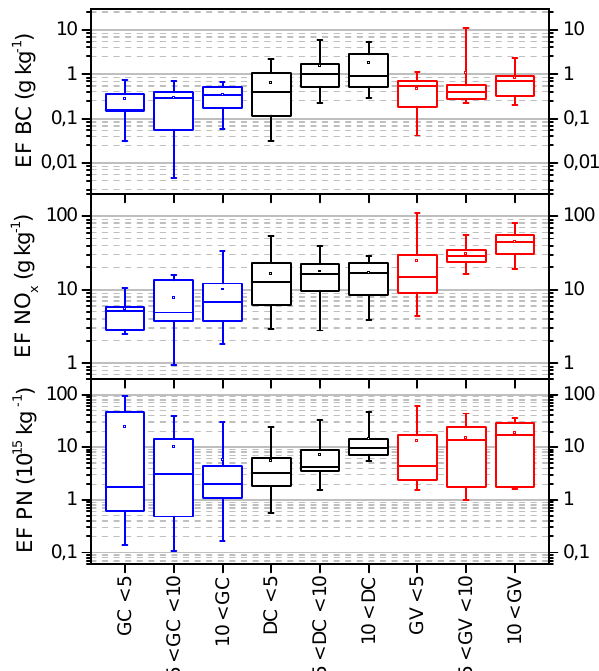
Figure 3. BC, NO x and PN EFs according to different vehicle cat- egories and age group subcategories: gasoline passenger cars (GC, blue), diesel passenger cars (DC, black), and goods vehicles (GV, red). Note the EF logarithmic scale; same figure in linear scale can be found in Supplement Fig.